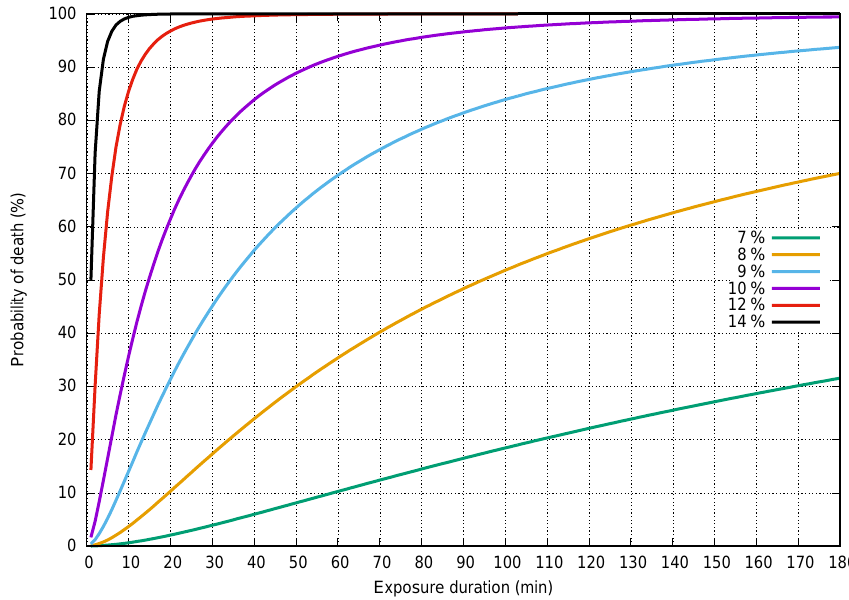
Figure 1. Percentage of fatalities (probability of death in %) depending on exposure duration (in min) according to Eq. (7). Values are shown for different values of CO 2 concentration ranging from 7 to 14% vol.